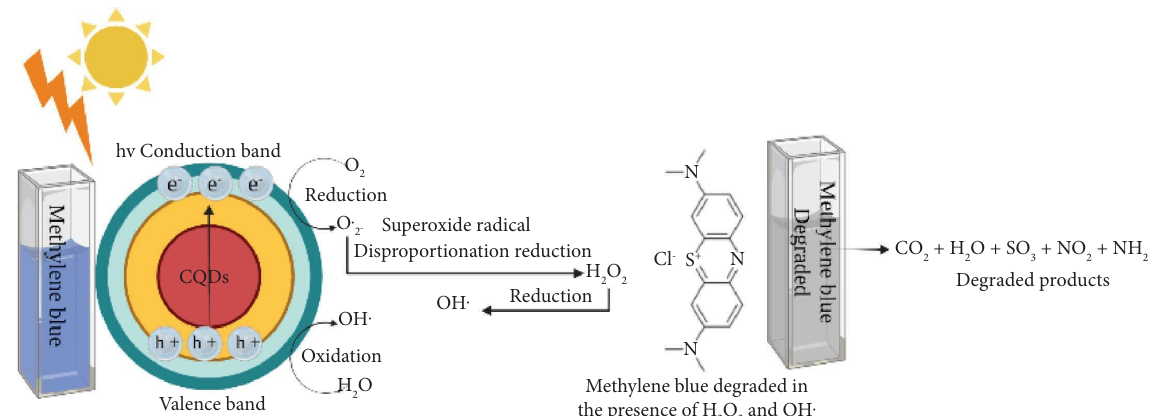
Figure 7: Schematic representation for photocatalysis of MB dye in the presence of